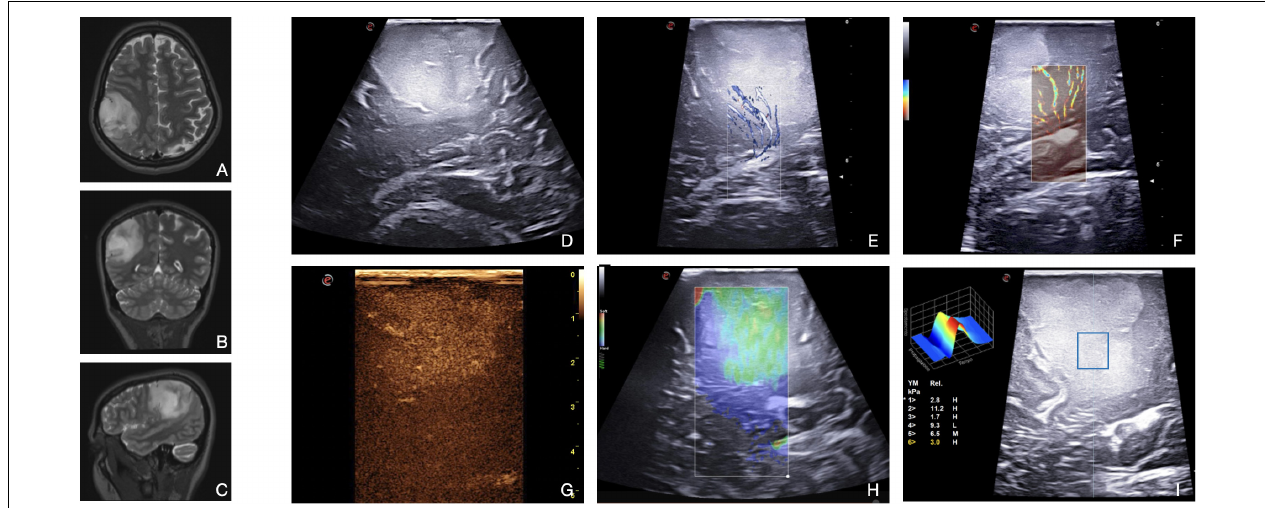
FIGURE 5 | Illustrative case of a diffuse astrocytoma (Grade 2 WHO, 2021). (A–C) Pre-operative MRI demonstrates a right frontal-temporal-parietal low-grade, non-enhancing intra-axial tumor. (D) In B-mode, LGG appears as a hyperechoic diffuse mass with blurred margins. Both X-flow Doppler (E) and Micro-V (F) demonstrate the venous drainage toward the ependyma. CEUS (G) allows to differentiate peritumoral edema from tumoral tissue. Typically, LGG shows a mild, dotted CE with homogenous pattern. SE (H) and SWE (I) allow a qualitative and quantitative evaluation, respectively, of the stiffness of the lesion. This information can be exploited to identify the interface between tumor and brain as shown in image (H) (the lesion appears green-softer than the parenchyma beneath).